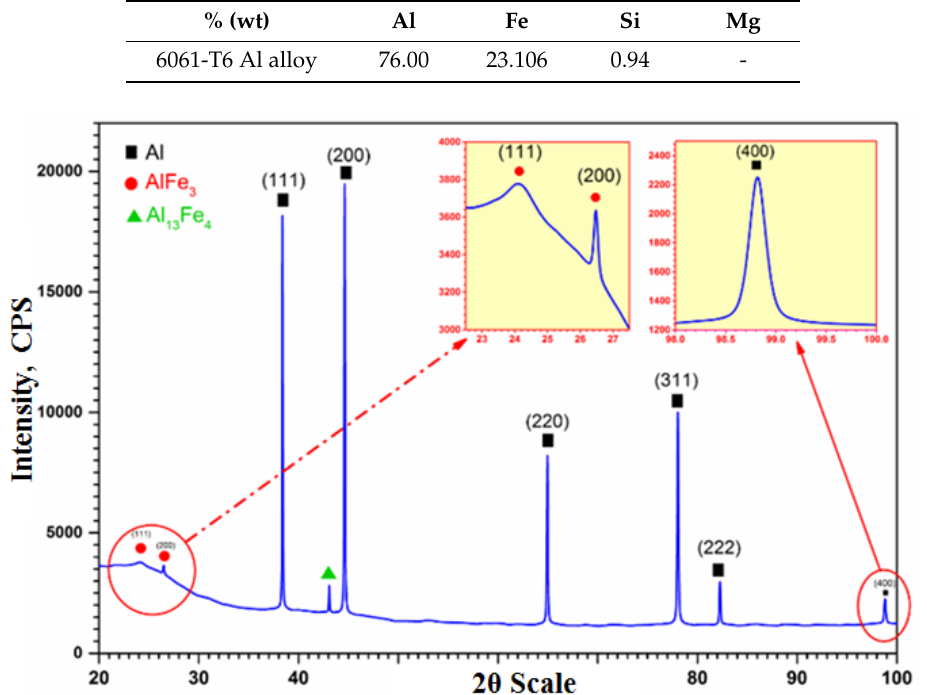
Figure 9. XRD diffractogram of aluminum side of welded joint by friction stir welding of aluminum alloy AL6061-T6 to ultra low carbon